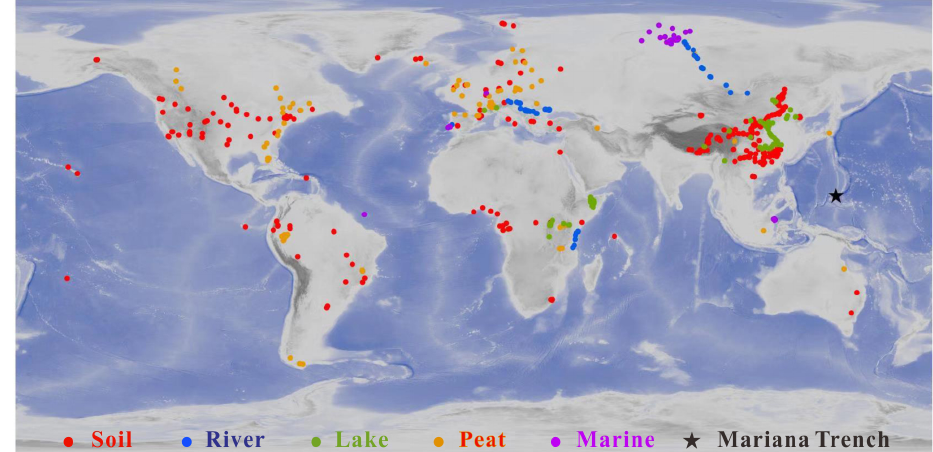
Figure 1. Location of the samples in this study. Red, orange, gray, blue and purple circles indicate globally distributed soil, river, lake, peat, and marine samples, respectively. Black star denotes the sediment core in the Mariana Trench. Detailed information is provided in the